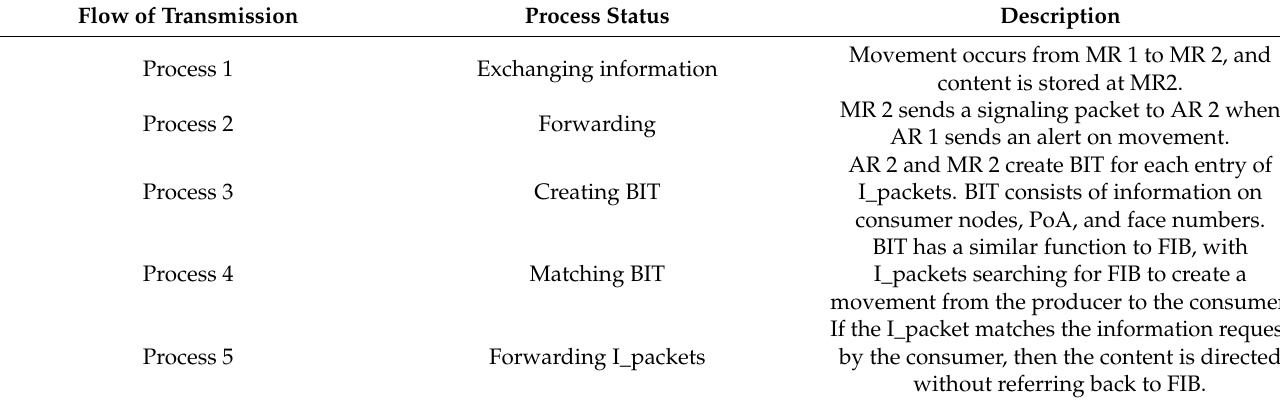
Table 4. Hybrid Operation.